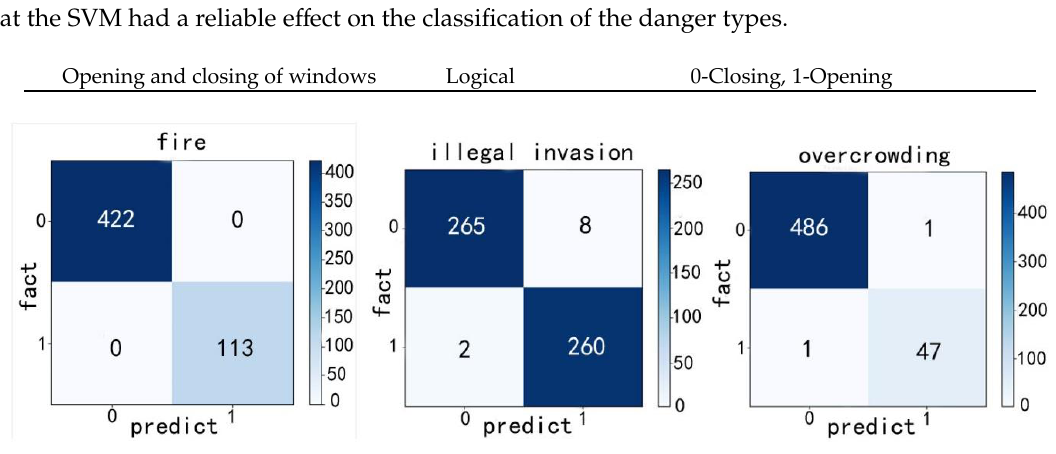
Figure 15. Test confusion matrices for the different danger types. Table 5. Evaluation indices for danger classification using the SVM.